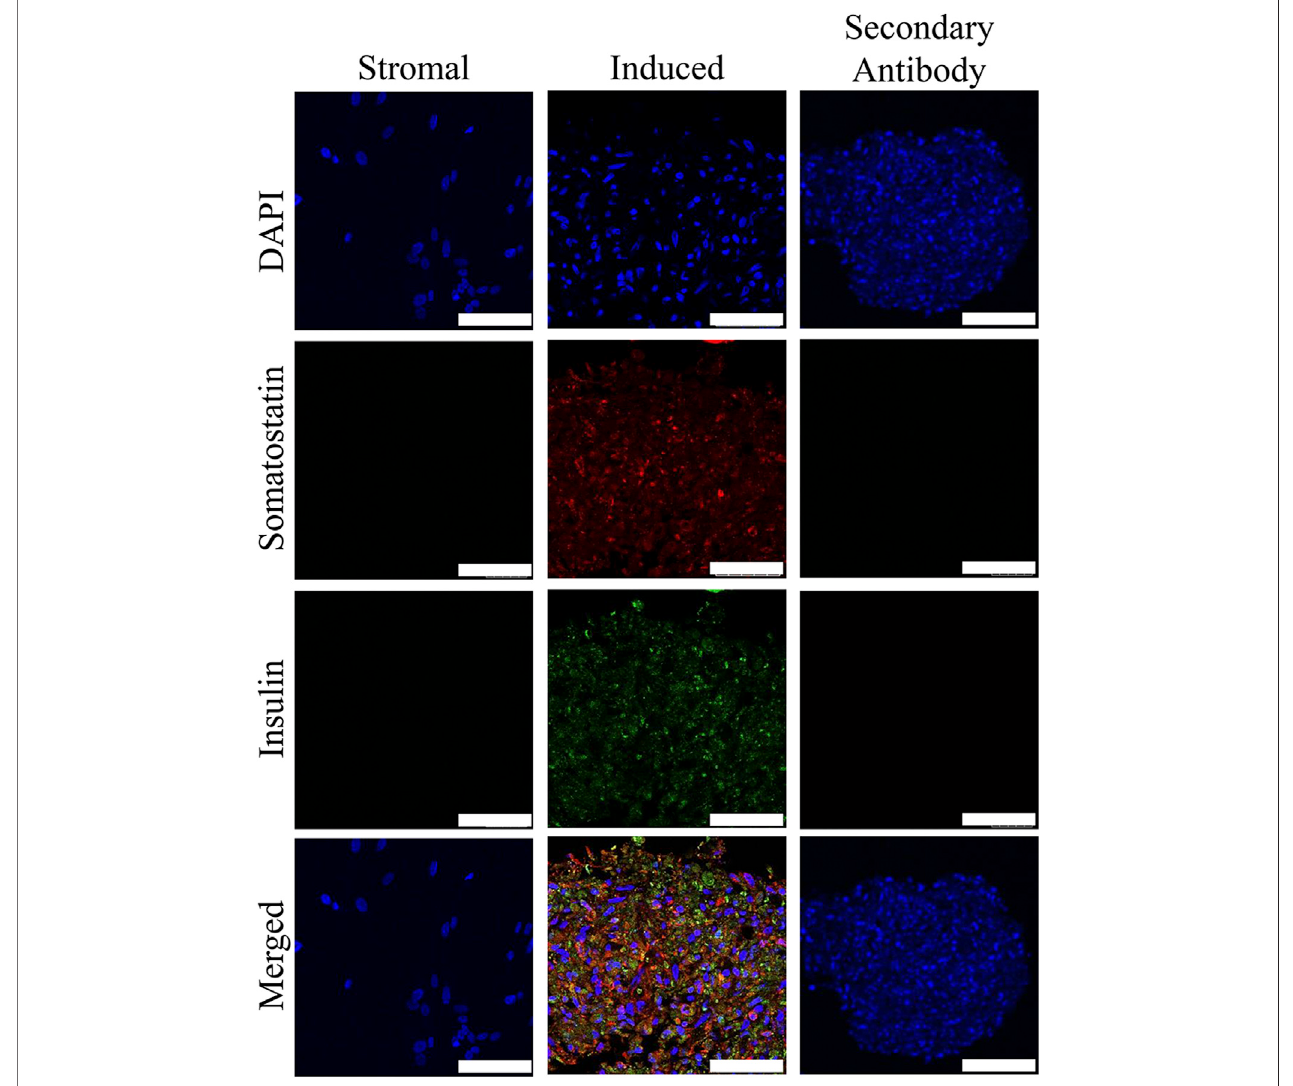
FIGURE4| Fluorescent photomicrographsofcellclustersafterculture instromalmedium (Stromal)orthreestages ofpancreatic induction medium (Induced) from pooled male and female feline ASCs labeled with DAPI (blue), somatostatin (red) and insulin (green). Clusters labeled with only the secondary antibody (Secondary Antibody) are also shown. Scale bars = 50